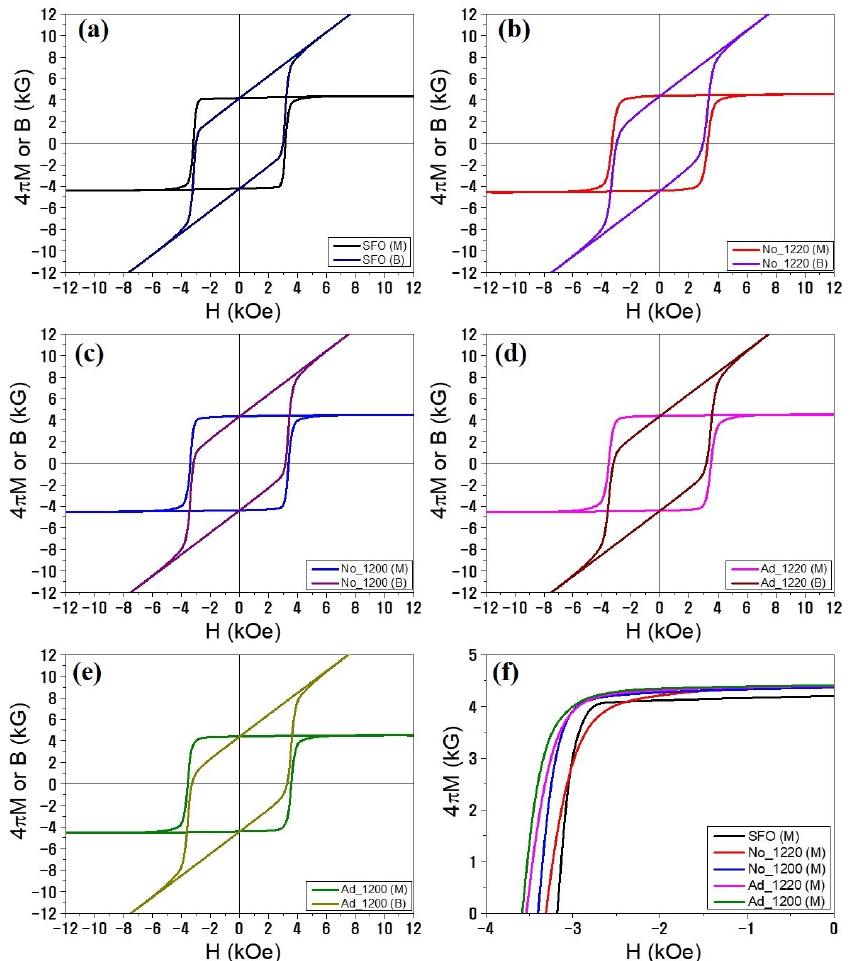
Figure 7. Plots of magnetization (4 π M ) and magnetic flux density ( B ) vs. H for anisotropic magnets with compositions of ( a ) SrFe 12 O 19 and ( b – e ) Sr 0.4 Ca 0.3 La 0.3 Fe 10.2 Co 0.1 Mn 0.1 Si 0.05 Mg 0.05 O 19 sintered at 1200 ◦ C and 1220 ◦ C with and without sintering additives. ( f ) Demagnetization (4 π M vs. H ) curves of all the magnets. Table 3. Sintered sample density ( ρ ), saturation magnetization (4 π M S ), intrinsic coercivity (kOe), normal coercivity (bH C ), remanent magnetization (B r ), and maximum energy product (BH max ) of hexaferrites magnets with composition of SrFe 12 O 19 (SFO) and Sr 0.4 Ca 0.3 La 0.3 Fe 10.2 Co 0.1 Mn 0.1 Si 0.05 Mg 0.05 O 19 sintered at 1200 ◦ C and 1220 ◦ C with and without sintering additives, respectively.